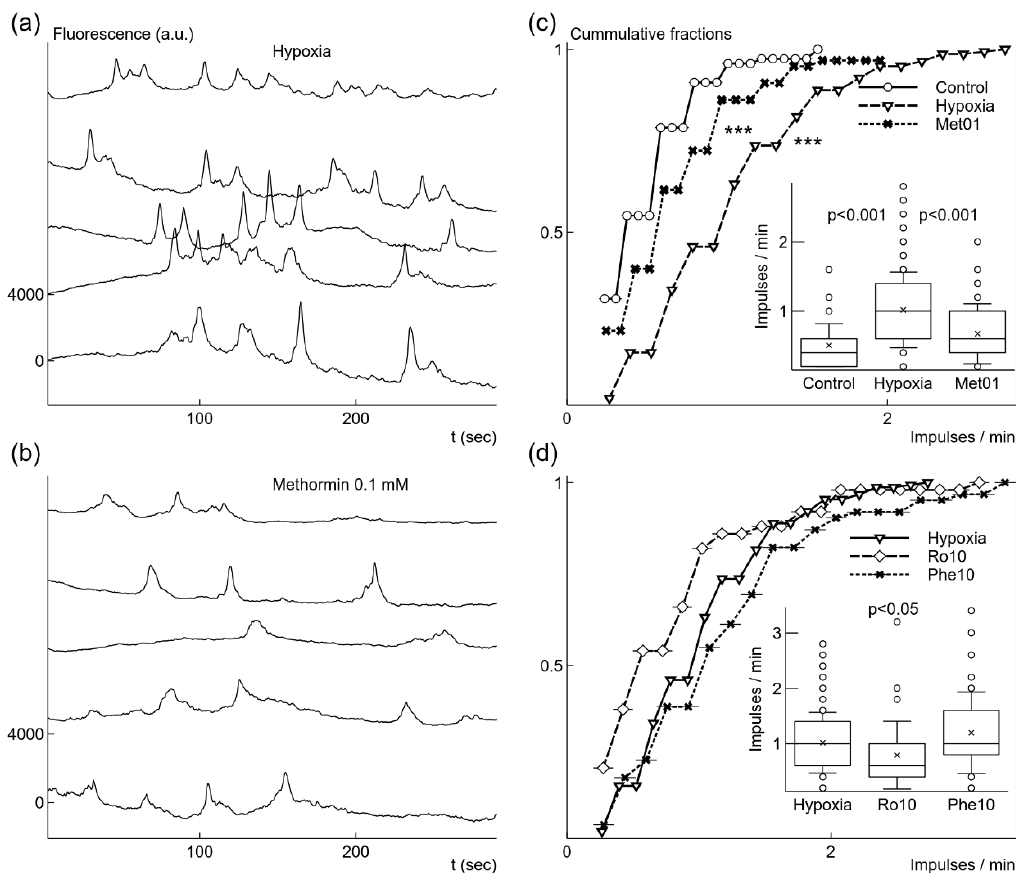
Figure 4. Changes of spontaneous Ca 2+ signal generation induced by growth under mild hypoxic conditions with or without additional drugs. Microglial cells grown under mild hypoxic conditions showed elevated rate of spontaneous Ca 2+ signals ( a ). Addition of 0.1 mM metformin before mild hypoxic conditions reduced the rate of Ca 2+ signal generation ( b ). Elevation of generation rate after hypoxia comparing to cells grown under normoxia was significant as illustrated by cummulative fractions and box-and-whisker plot ( c ). Reduction of generation rate by adding 0.1 mM metformin (Met01) ( c ) was also statistically significant comparing to the rate after mild hypoxia without metformin. 10 nM rotenone (Ro10) added before mild hypoxic conditions weakly reduced the rate of spontaneous signal generation ( d ), although the difference was not statistically significant for cummulative fractions. However, 10 μM phenformin (Phe10) did not change the rate ( d ). Fluorescence traces were shifted by 4000 a.u. in relation to each other in ( a ) and ( b ). *** p < 0.001 (Kolmorogov – Smirnov test), p from Welch’s t -test in box-and-whisker plots.